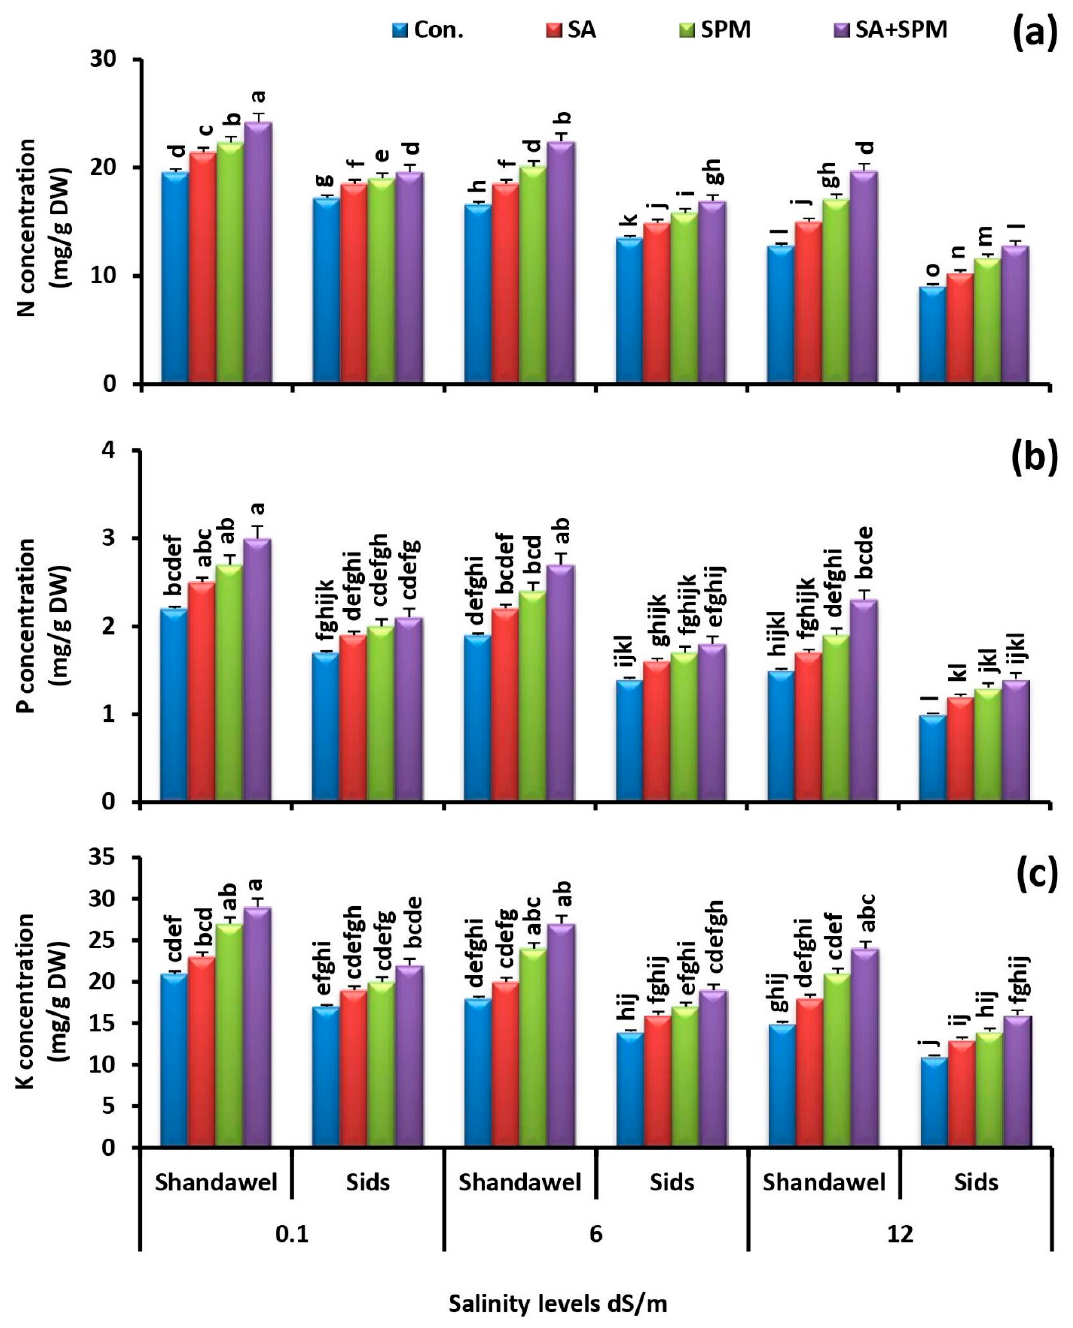
Figure 5. Influence of salicylic acid (SA; 100 mgL − 1 ) and/or spermine (SPM; 30 mgL − 1 ) on the concentration of ( a ) nitrogen, ( b ) phosphorus, and ( c ) potassium in grains of two wheat cultivars (Shandawel 1 and Sids 14) grown under 0.1, 6, and 12 dS m − 1 salinity levels. Data are mean of four replicates (n = 4). Different letters indicate significant differences at ( p < 0.05) level according to Duncan’s test.